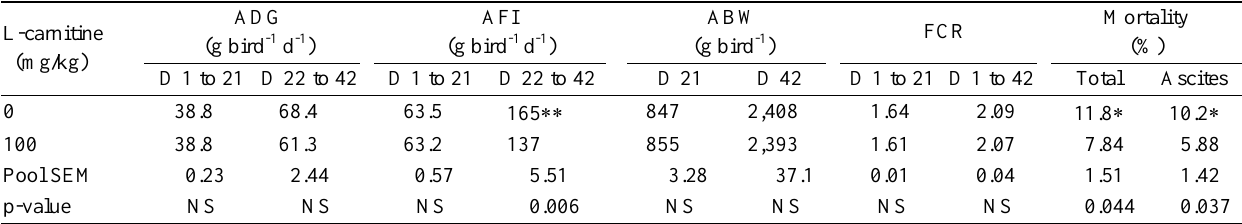
Table 2. Effects of dietary L-carnitine supplementation on broiler growth performance and mortality a